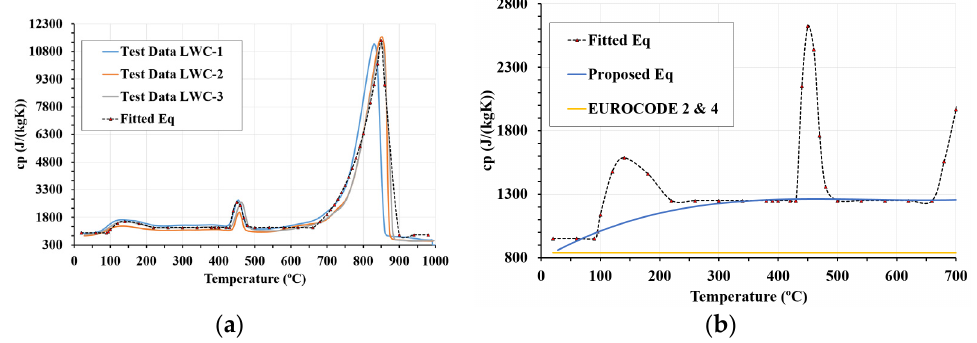
Figure 10. Specific heat: ( a ) comparison of the experimental and proposed specific heat equations; ( b ) comparison of proposed equations, simplified equation, and Eurocodes 2 and 4 values.